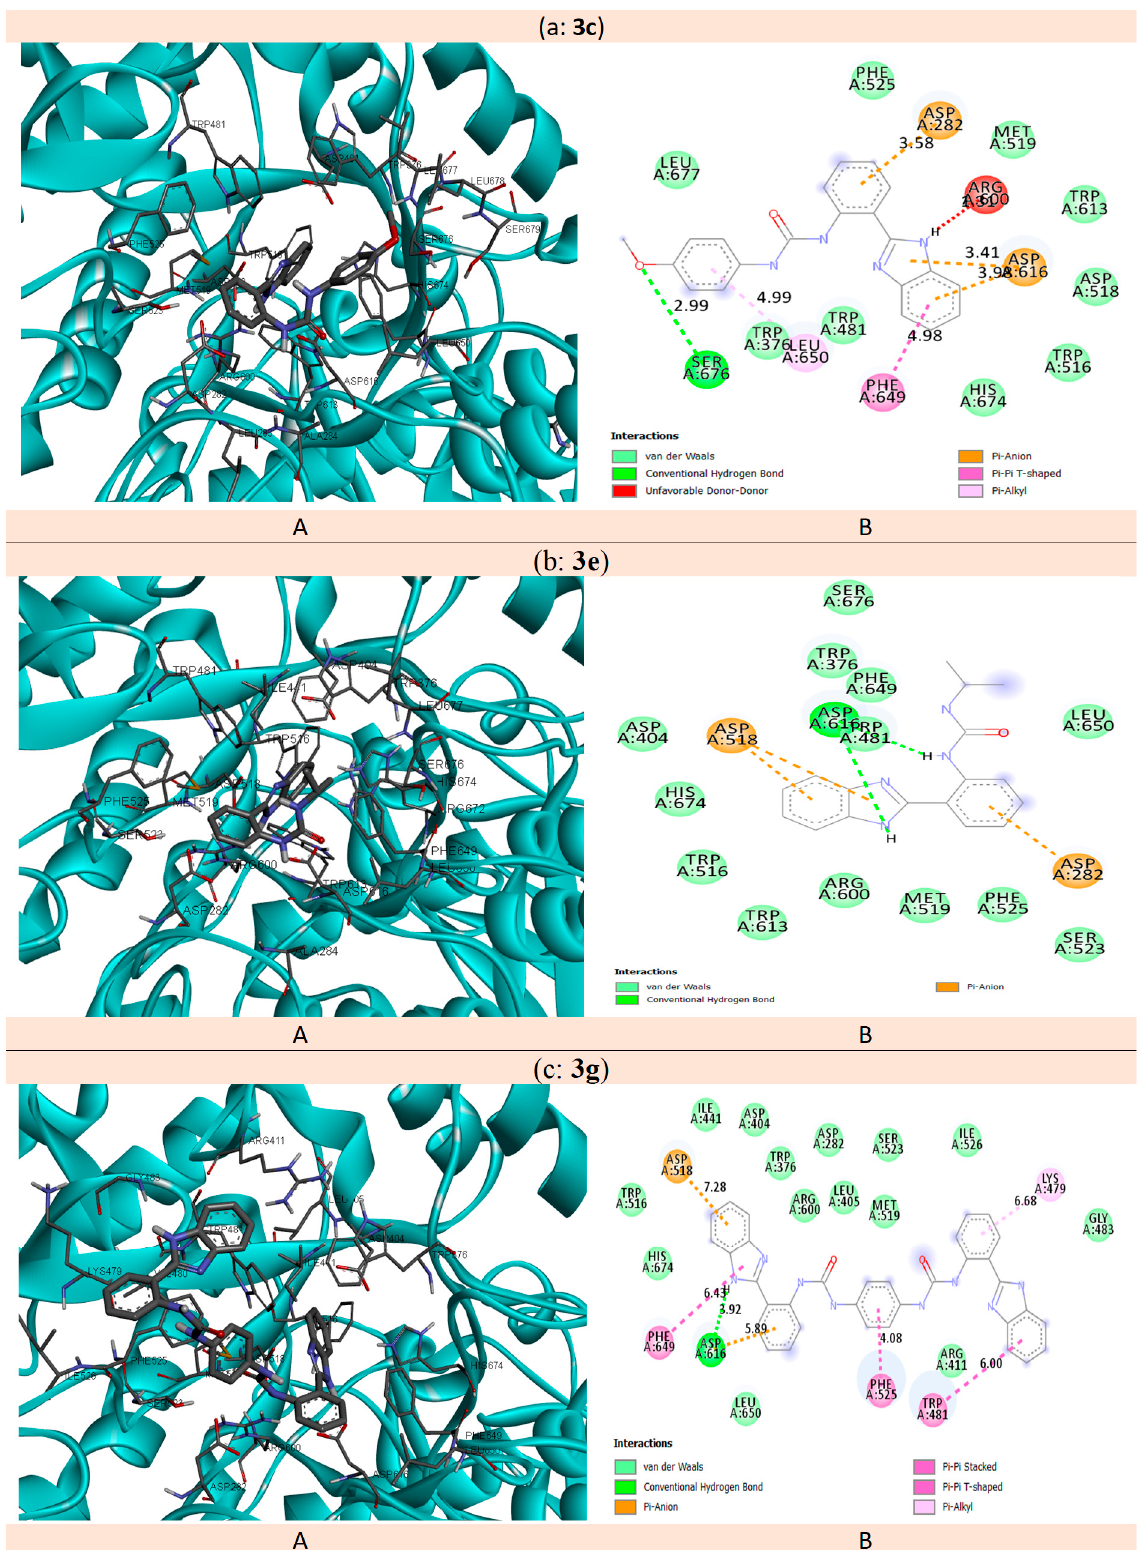
Figure 7 . The interaction types of ( a ) 3c , ( b ) 3e , and ( c ) 3g with surrounding amino acids of HLAG are shown in 3D ( A ) and 2D ( B ).